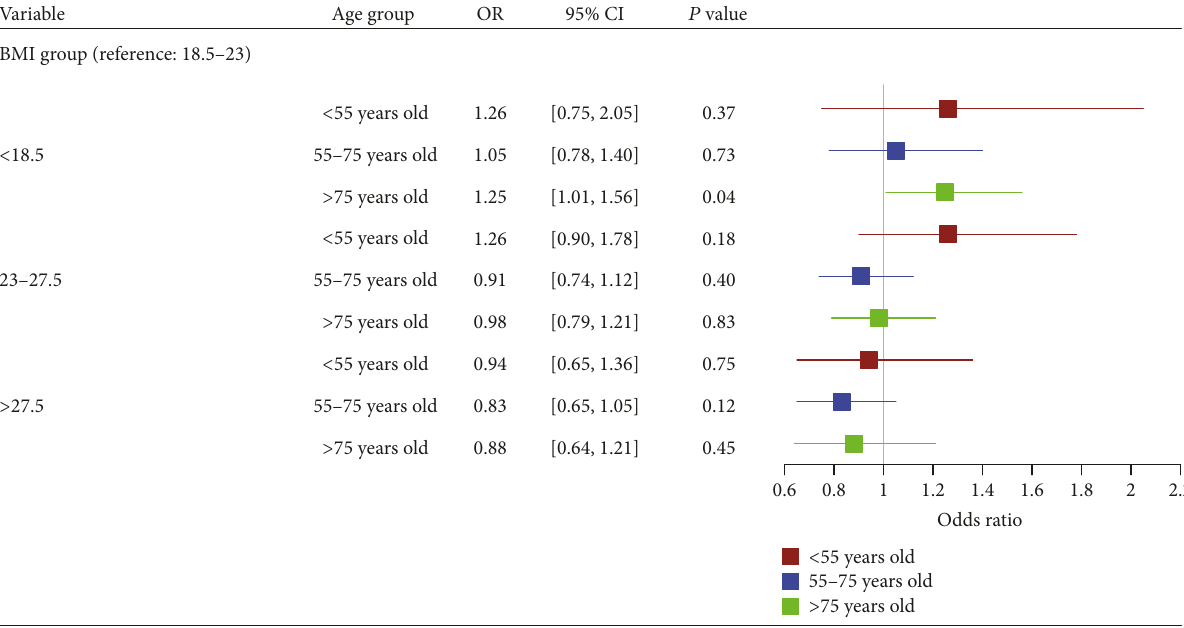
Figure 4: Multivariate logistic regression models for studying the relationship between body mass index (BMI) and acute kidney injury (AKI) for different age groups of hospitalised patients (total number of patients under 55 years of age = 3960, where patients with AKI = 259; total number of patients aged 55–75 years = 4796, where patients with AKI = 681; total number of patients above 75 years old = 3799, where patientswithAKI=666). Note .BMI:bodymassindex;CI:confidenceinterval;OR:oddsratio.Adjustedvariablesinlogisticregressionmodels include age, gender, ethnicity, background diagnoses (cardiovascular disease, chronic kidney disease, diabetes mellitus, hepatobiliary disease, psychiatric illness, and gastrointestinal disease), primary diagnoses (infectious and parasitic diseases, neoplasm, diseases of the genitourinary system, diseases of the musculoskeletal system and connective tissue, and symptoms, signs, and ill-defined conditions), and procedures (otolaryngology related surgery, endoscopy, open laparotomy, and cardiology related percutaneous procedures).